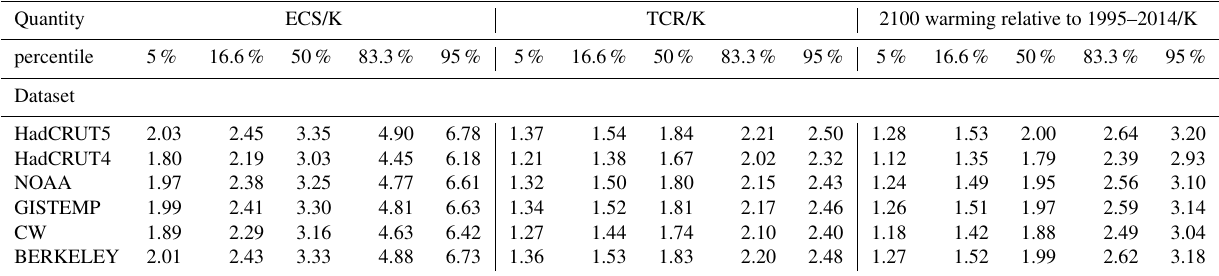
Table 9. Sensitivity of results for the key metrics to the choice of observational dataset used in the Global Warming Index calculation. Quantity ECS/K TCR/K 2100 warming relative to 1995–2014/K percentile